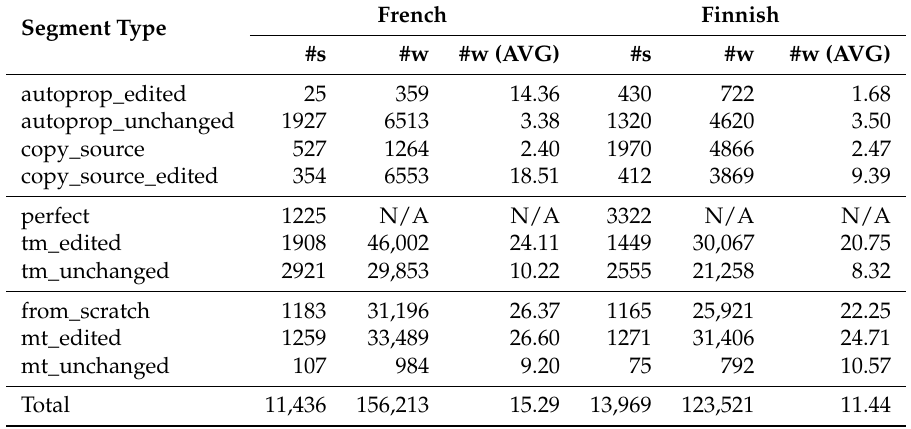
Table 1. Total number of segments (#s), total number of source words (#w) and average number of source words (#w (AVG)) per segment, for French and Finnish, per segment